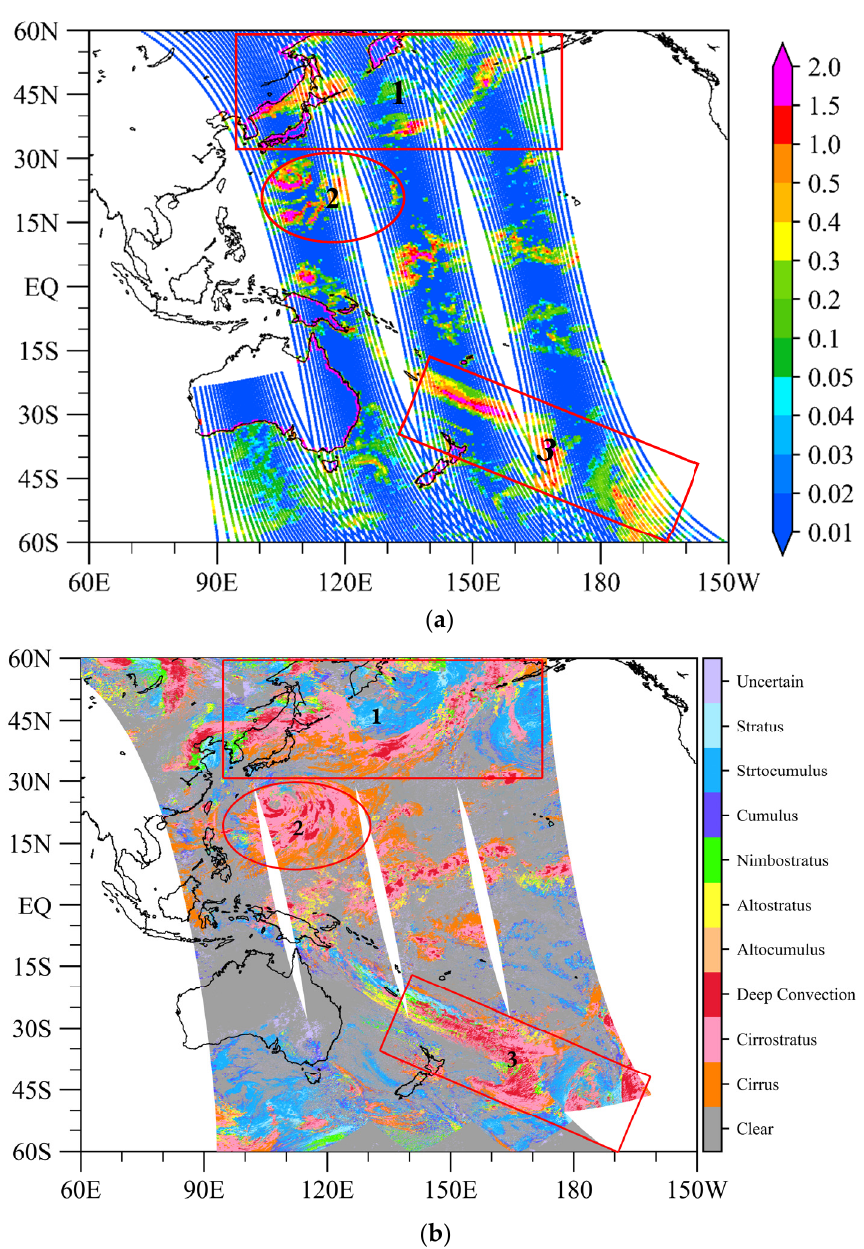
Figure 1. Spatial distribution of the whole-layer-integrated LWP ( a ) from NOAA19 during 0300– 0900 UTC and ( b ) from the MODIS cloud classification products during 0000–0600 UTC over the western Pacific on 12 August 2019. the western Pacific on 12 August